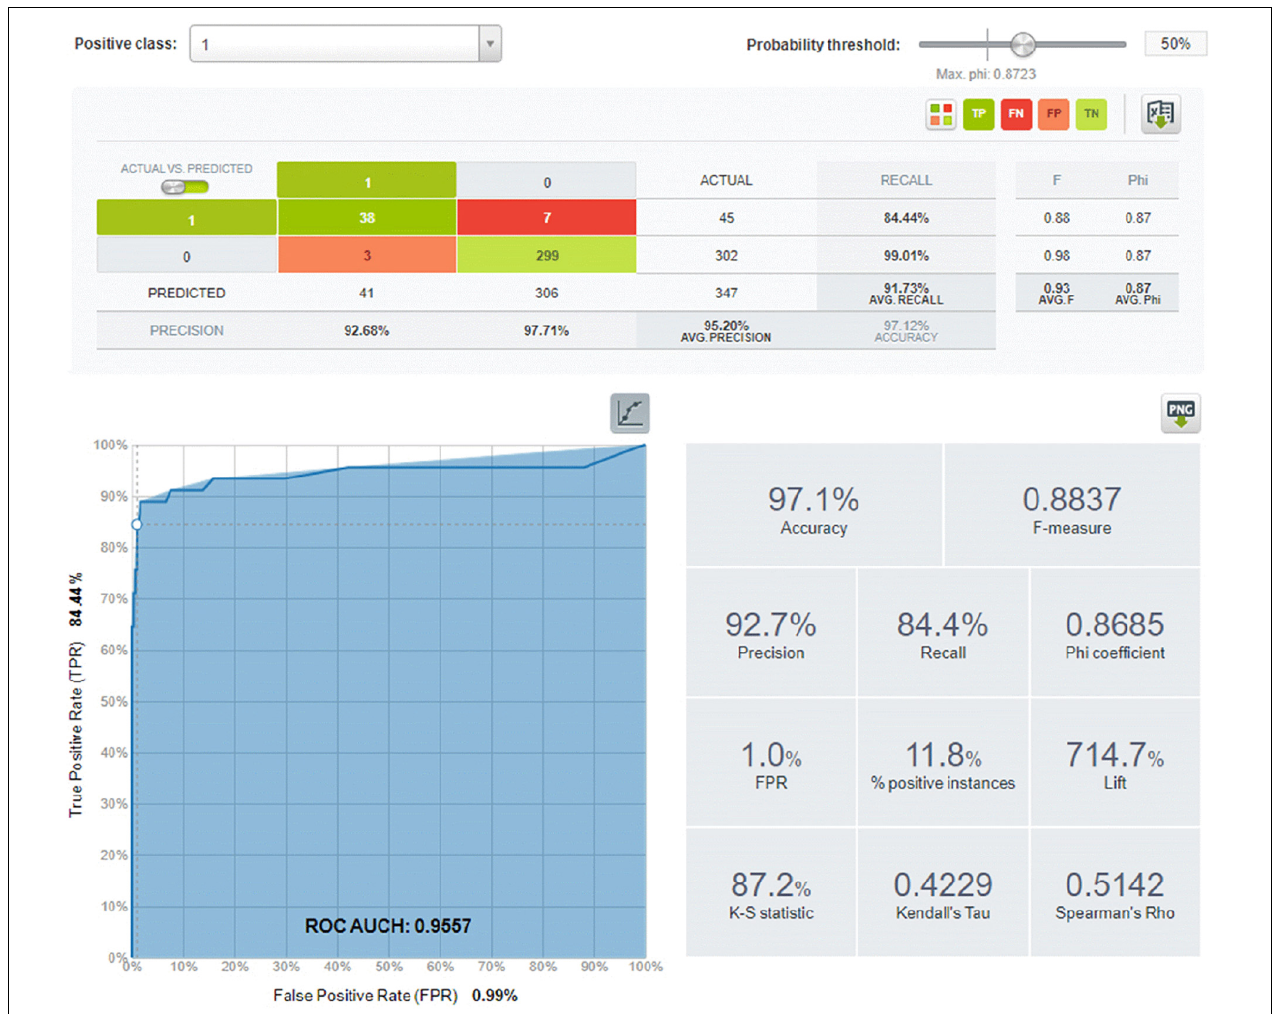
FIGURE 5 | Machine learning and ROC analysis results for 1-year data: next-day M3–4 EQ forecast results for the Ajameti well area ( R = 200